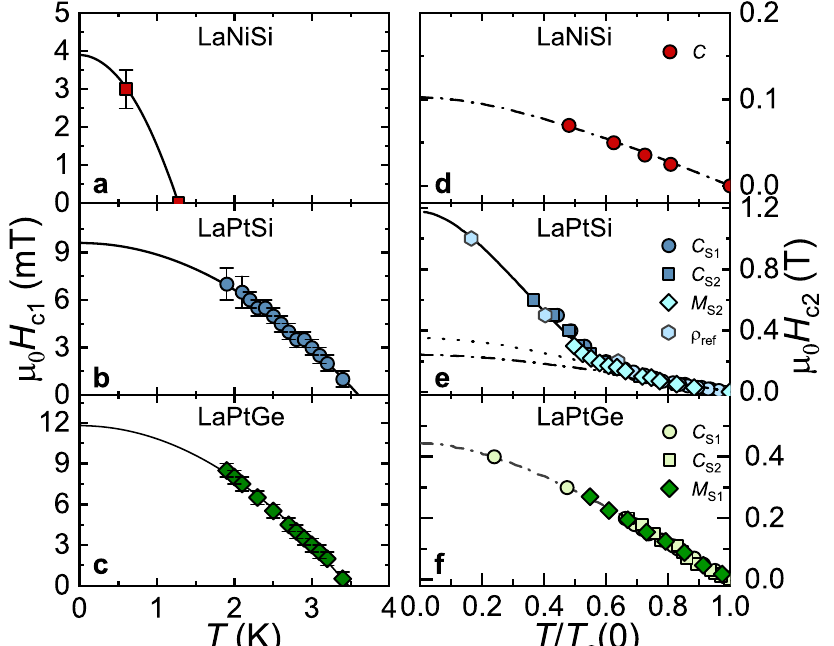
Fig. 2 Lower and upper critical fi elds. a – c The lower critical fi elds H c1 as a function of temperature for LaNiSi ( a ), LaPtSi ( b ), and LaPtGe ( c ). For each temperature, H c 1 was determined as the value where the fi eld-dependent magnetization M ( H ) starts to deviate from linearity (see Supplementary Fig. 3 and Note 3). Solid lines are fi ts to μ 0 H c1 ð T Þ ¼ μ 0 H c1 ð 0 Þ½ 1 (cid:2) ð T = T c Þ 2 (cid:3) . d – f Upper critical fi elds H c2 versus the reduced temperature T / T c for LaNiSi ( d ), LaPtSi ( e ), and LaPtGe ( f ). The superconducting transition temperatures T c were determined from heat- capacity- C ( T ) and magnetization measurements M ( H ) (see details in Supplementary Figs. 4 – 6 and Note 4). For LaPtSi and LaPtGe, two different sample batches (denoted as S1 and S2) were measured. The dash-dotted-lines, dashed-lines, and solid-lines are fi ts using WHH-, GL-, and two- band models, respectively. The H c2 values determined from ρ ( T , H ) from ref. 5 are also plotted in e for LaPtSi. The error bars of H c1 are the fi eld- step values used during the M ( H )